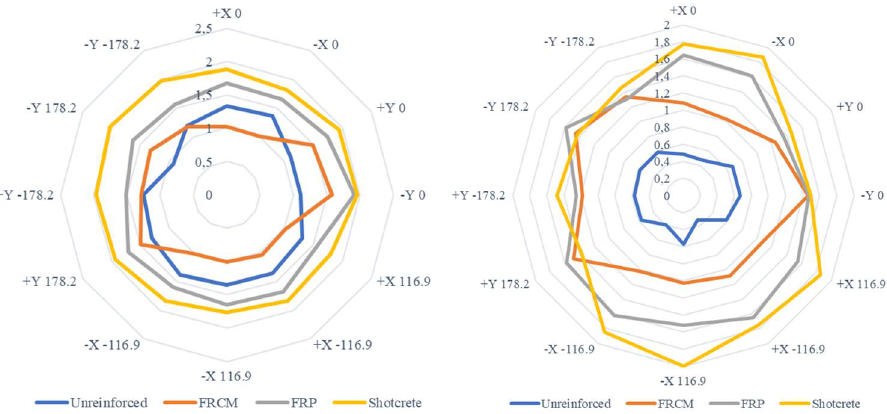
Figure 26. Comparison of vulnerability indices (Significant Damage limit state) of the unreinforced model and all strengthening methods (uniform load distribution—( left ), modal load distribution— ( right )).